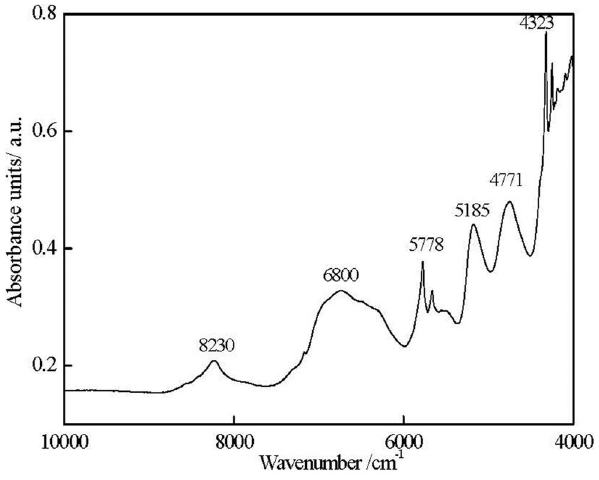
Figure 5. Correlation between predicted values and actual values of adsorptive ink weight of